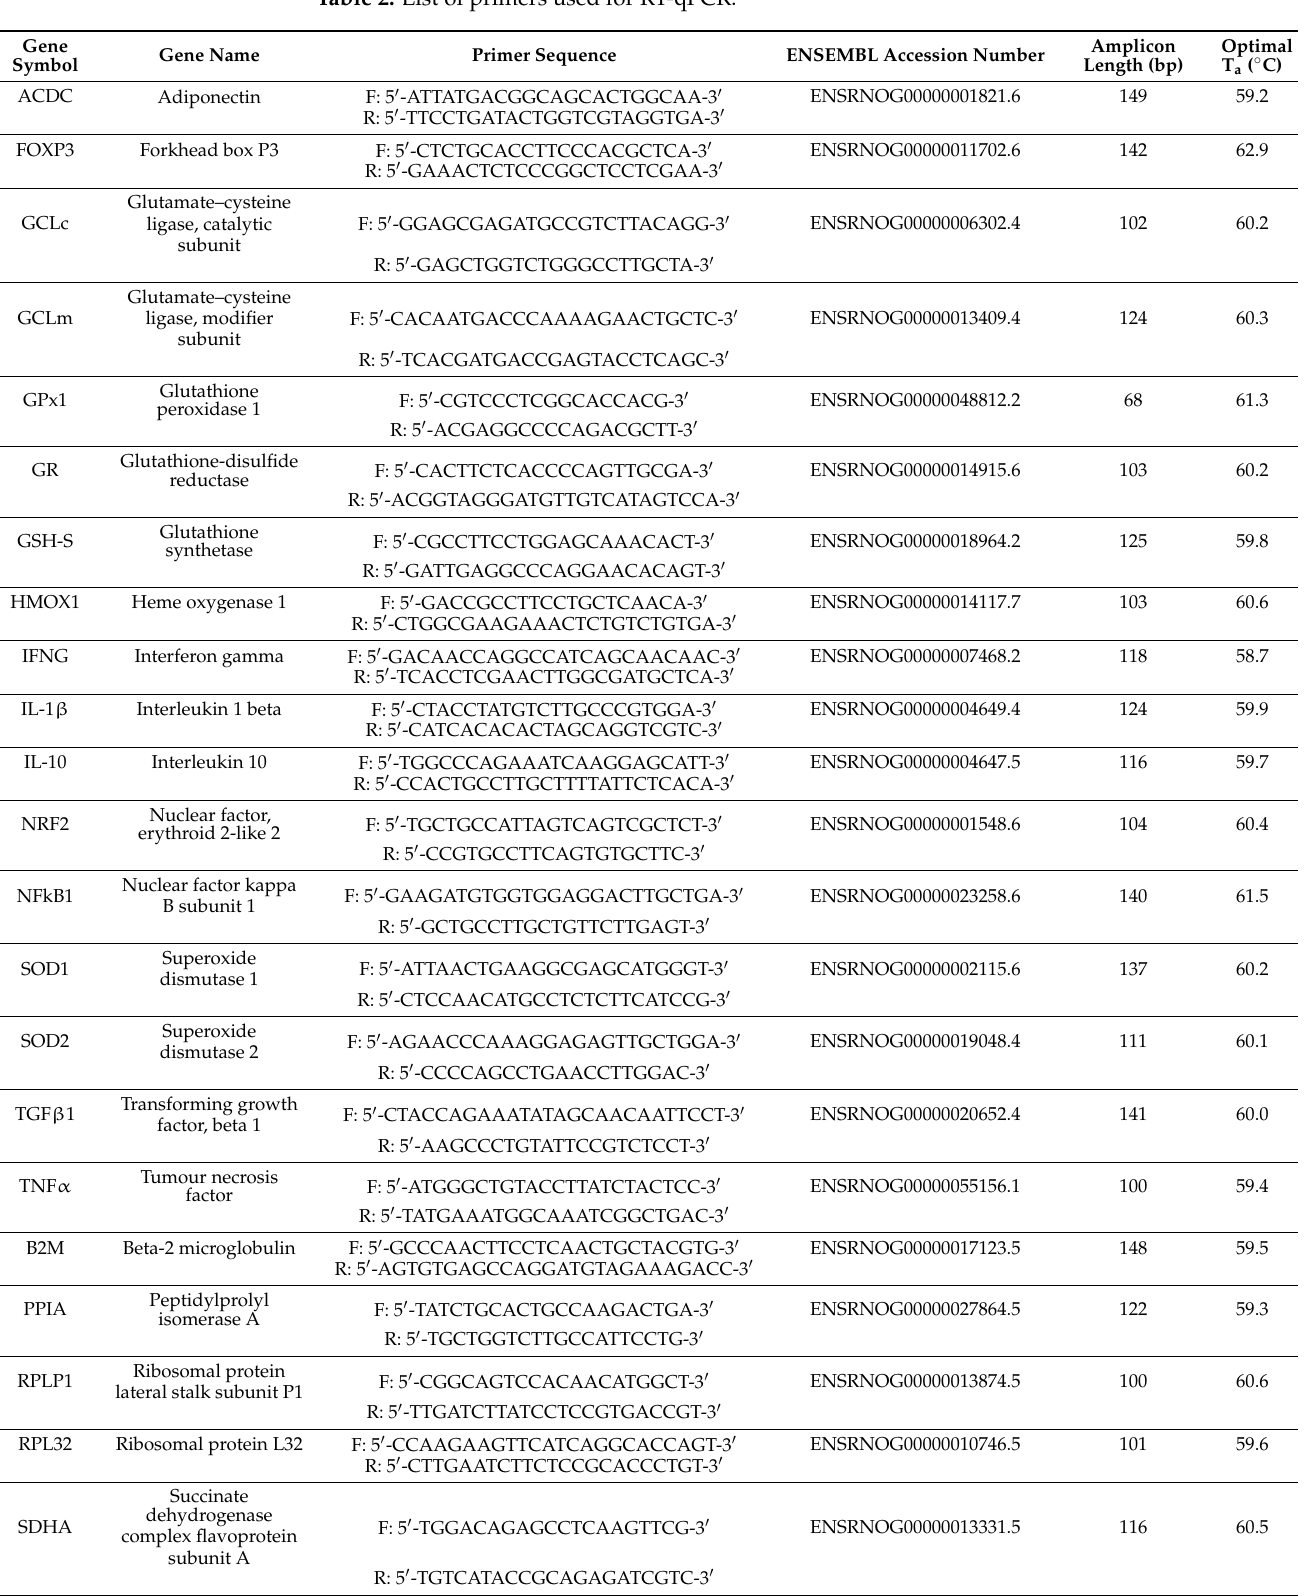
Table 2. List of primers used for